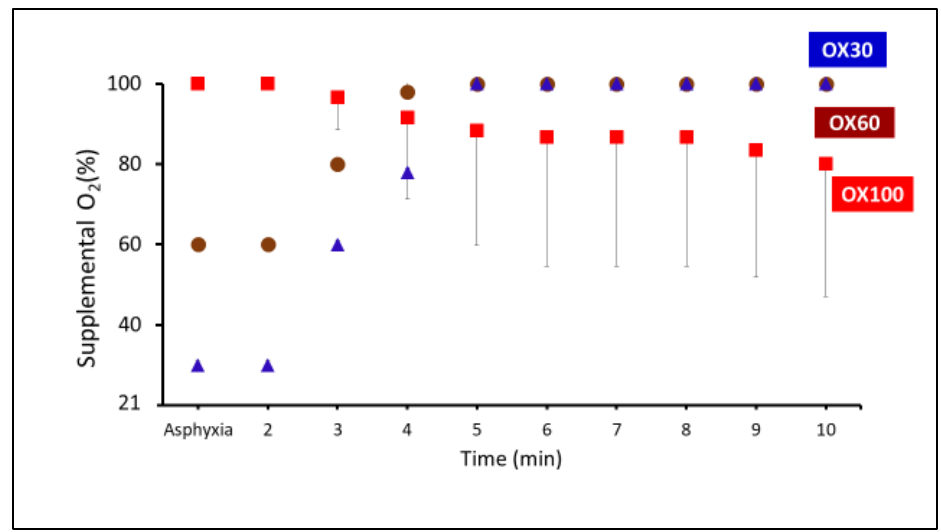
Figure 2. The graph represents the supplemental oxygen used during the resuscitation in OX30 (tri ‐ angle), OX60 (circle), and OX100 (square) groups. The oxygen was titrated after 2 min. Data are represented as average and standard deviation.